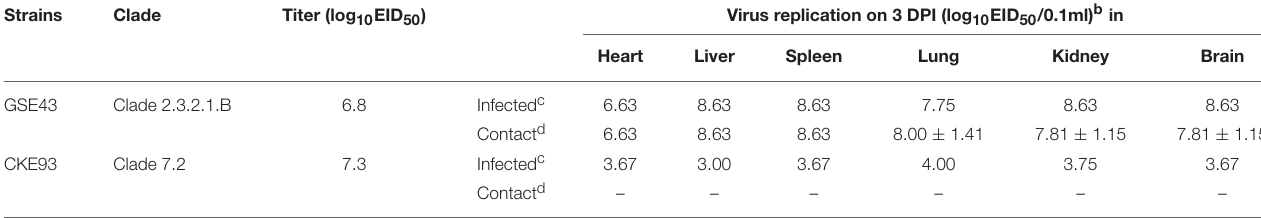
TABLE 3 | Replication and lethality in chickens of the H5N1 viruses after inoculated intranasally a . Strains Clade